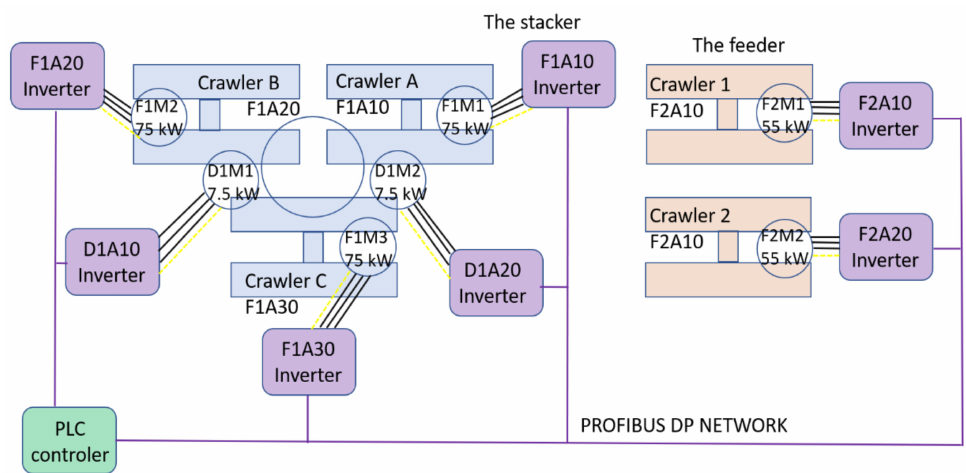
Figure 1. Block diagram of the electrotechnical drive system used in the stacker machine [1,6,7]. Three inverters (F1A10, F1A20, F1A30) are used for the control stacker induction motors (F1M1, F1M2, F1M3) with nominal power P N = 75 kW. To tune the stacker, we use two inverters (D1A10, D1A20) and two induction motors (D1M1, D1M2) with nominal power P N = 7.5 kW. For the feeder, we have two inverters (F2A10, F2A20) which